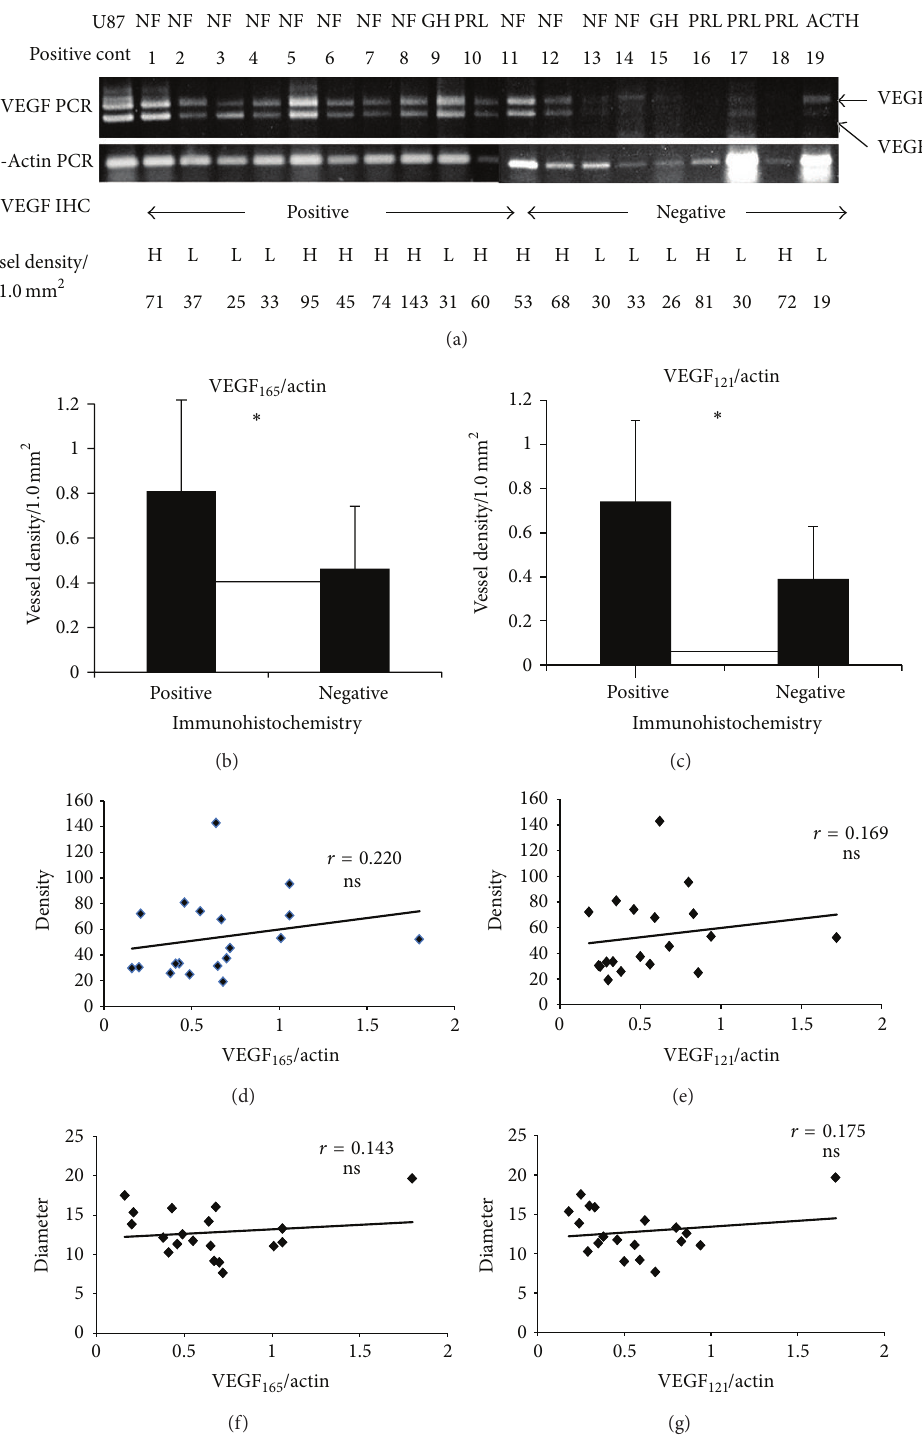
Figure 2: Determination of VEGF mRNA expression and immunohistochemistry. (a) VEGF mRNA expression and corresponding VEGF immunohistochemistry results (positive and negative) and vessel density (number/0.13mm 2 , 𝐻 ≥ 40 , 𝐿 < 40 ). (b) The VEGF 165 / 𝛽 -actin ratio was significantly higher in VEGF-positive group than the VEGF-negative group ( 𝑃 < 0.05 ). (c) The VEGF 121 / 𝛽 -actin ratio was significantly higher in the VEGF-positive group than the VEGF-negative group ( 𝑃 < 0.05 ). (d) The correlation between VEGF 165 / 𝛽 -actin ratio and vessel density was not significant ( 𝑟 = 0.22 ). (e) Correlation between VEGF 121 / 𝛽 -actin ratio and vessel density is not significant ( 𝑟 = 0.169 ). (f) Correlation between VEGF 165 / 𝛽 -actin ratio and vessel diameter is not significant ( 𝑟 = 0.143 ). (g) Correlation between VEGF 121 / 𝛽 -actin ratio and vessel density is not significant ( 𝑟 = 0.175